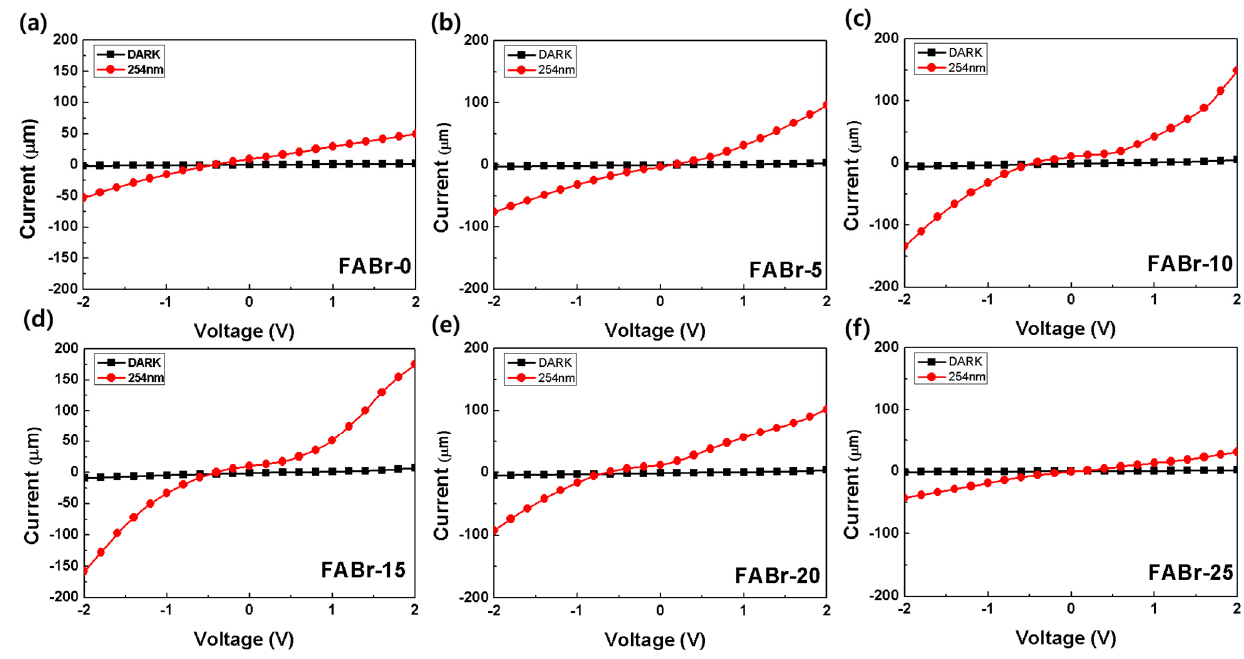
Figure 4. Current ‐ voltage (I − V) characteristics of mixed ‐ anion perovskite PDs as a function of FABr concentration. ( a ) FABr ‐ 0, ( b ) FABr ‐ 5, ( c ) FABr ‐ 10, ( d ) FABr ‐ 15, ( e ) FABr ‐ 20, ( f ) FABr ‐ 25. concentration. ( a ) FABr-0, ( b ) FABr-5, ( c ) FABr-10, ( d ) FABr-15, ( e ) FABr-20, ( f )